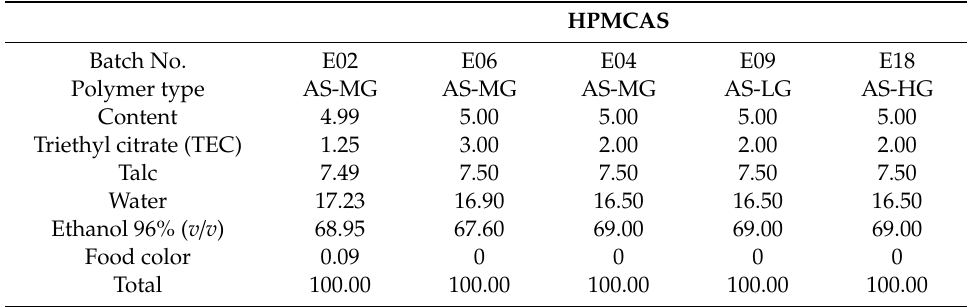
Table 3. Composition of HPMCP coating dispersion. All concentrations are given in percent ( w / w ). Batch No.